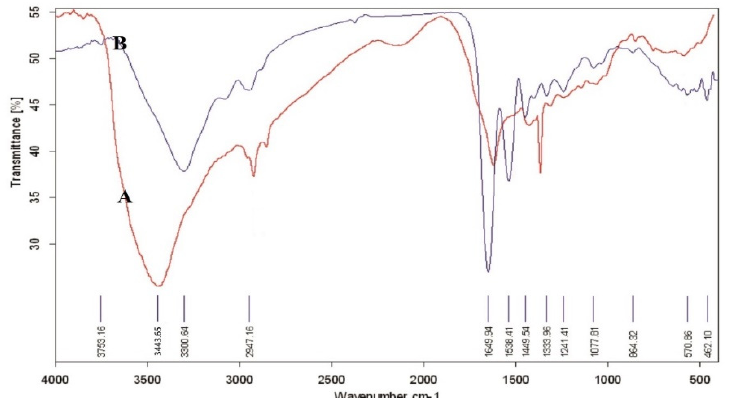
Figure 2. ATR-FTIR spectra of ( A ) untreated gelatin nanofibers, ( B ) atmospheric-air plasma-treated gelatin nanofibers. Table 2. ATR-FTIR band assignments of gelatin that were affected by atmospheric-air plasma treatment. Peak Position (cm − 1 )